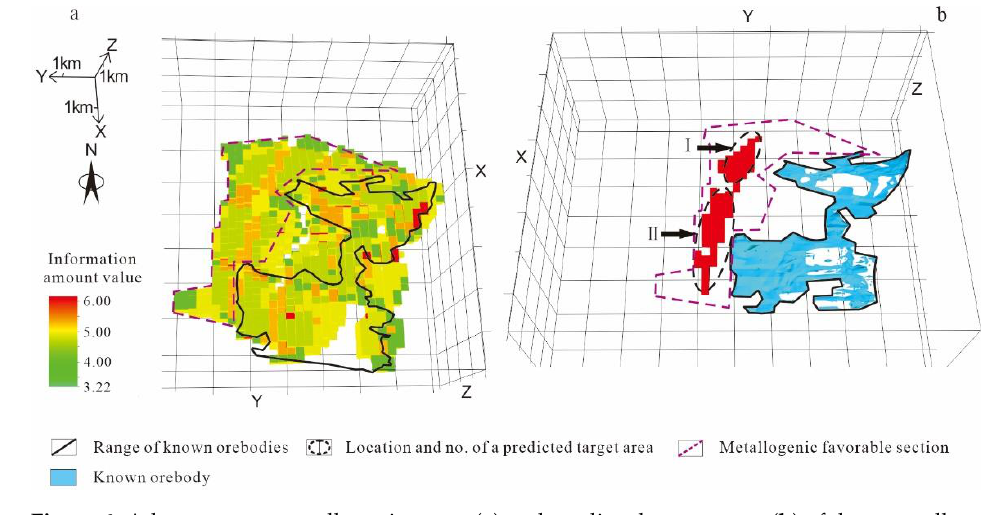
Figure 5. Histogram showing the proportion of metallogenic information amount intervals of cell blocks of the Jiaojia fault.